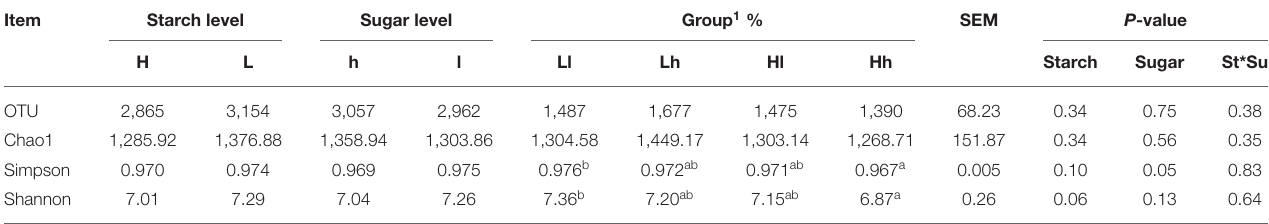
TABLE 4 | Effects of different combinations of sugar and starch on the alpha diversity of ruminal bacterial communities in vitro .